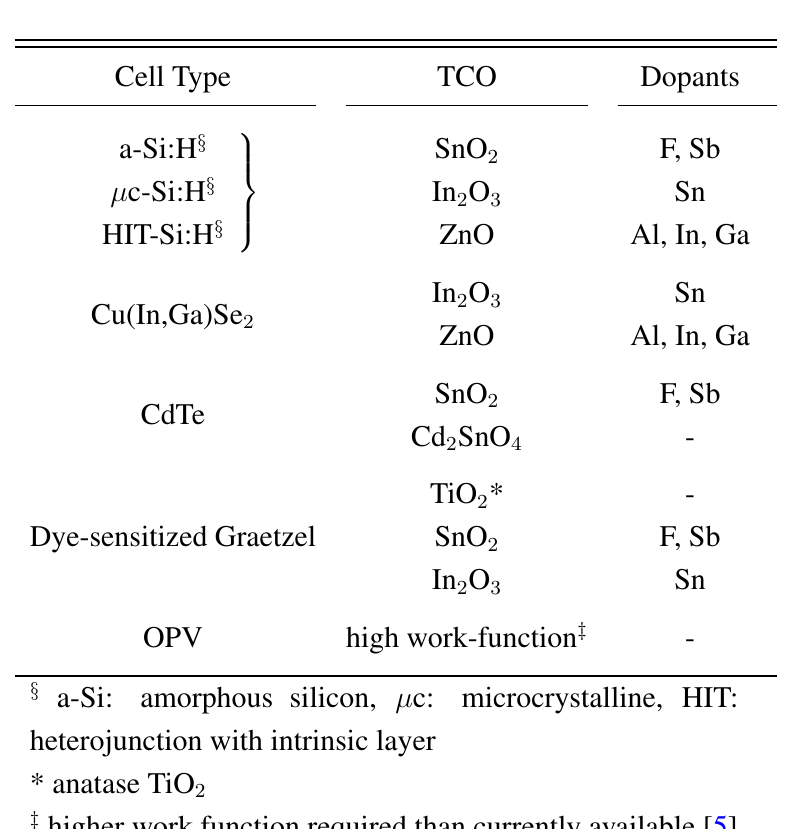
Table 1. TCOs employed in photovoltaic cells (after Fortunato